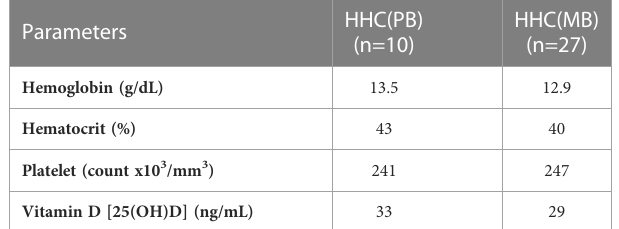
TABLE 1 Sociodemographic features and clinical-laboratorial records of the study